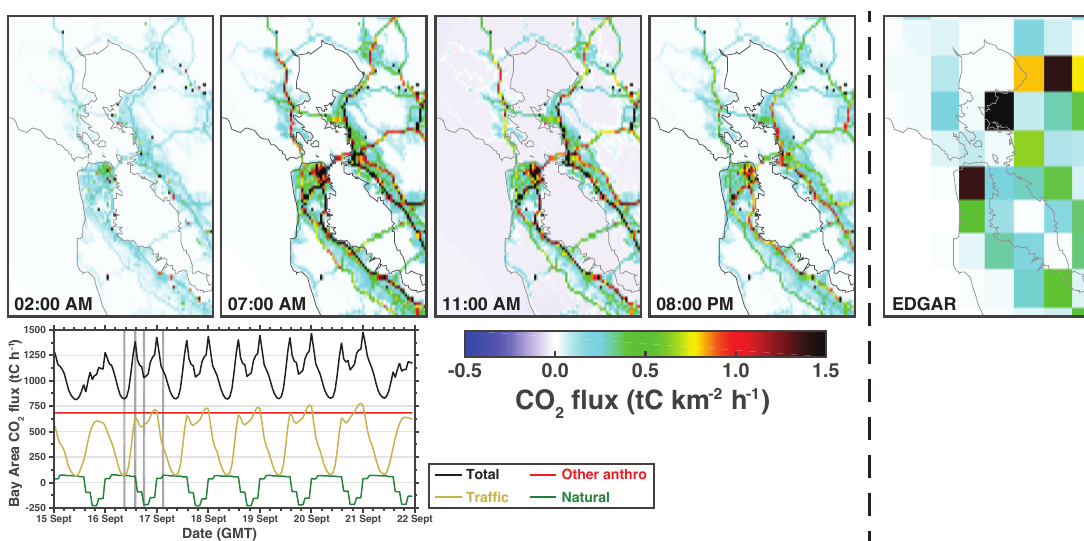
Figure 1. September 2013 CO 2 fluxes from bottom–up inventories. Top row shows the fluxes in the Bay Area (122.0357–122.7683 ◦ W, 37.3771–38.2218 ◦ N) at four representative hours (hour in local time). Right panel shows the atemporal EDGAR v4.2 FT2010 CO 2 flux in the Bay Area. Bottom panel shows the total Bay Area CO 2 flux (black), traffic (orange), other anthropogenic (red), and natural (green) sources. Vertical gray shading indicates the time slices plotted in the top and middle